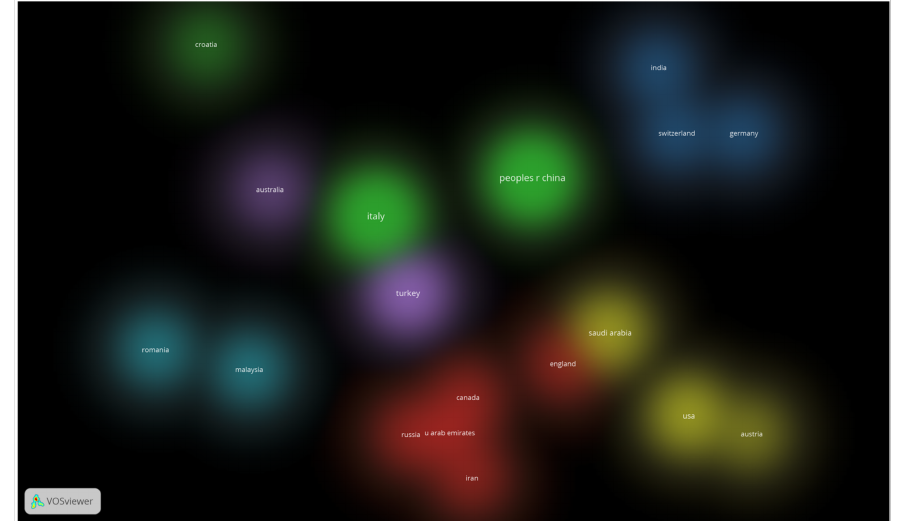
Figure 9. Citation and authors of countries. Source: Analysis by Authors through Vosviewer.